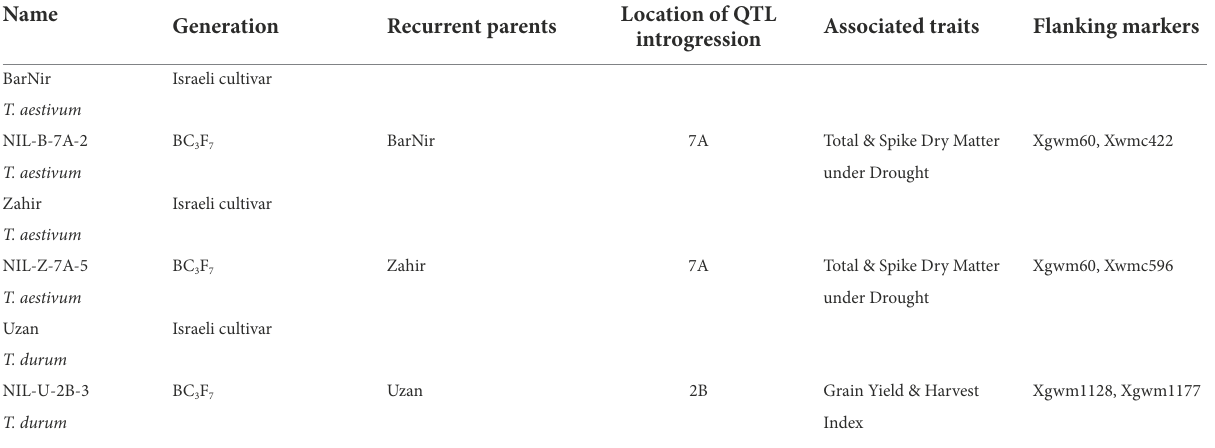
TABLE 1 Overview of used plant